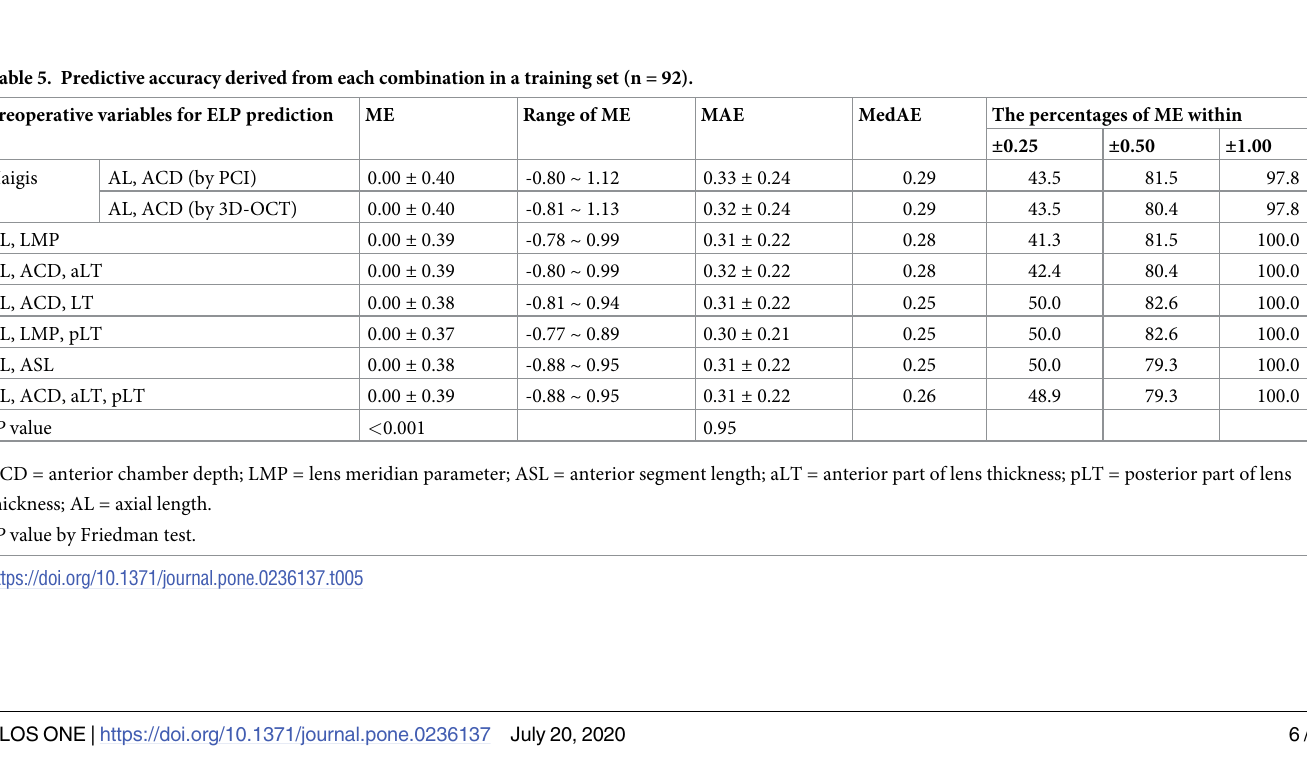
value = 0.40). Notably, the combinations of AL, LMP, and pLT, and of AL, ACD, aLT and pLT both showed the strongest correlation and smallest standard deviation of ELP prediction error (R 2 = 0.43, ELP error = 0.00 ± 0.28, respectively). Predictive accuracy derived from each combination is listed in Table 5. The combination of AL, LMP, and pLT yielded the smallest standard deviation of ME, narrowest range of ME, smallest maximum error, smallest MAE, smallest MedAE, and highest percentages within ± 0.25, ± 0.50, and ± 1.00 diopters. Fig 2 shows the correlation between preoperative LT and prediction error derived from each combination. The combinations of AL and ACD show significant negative correlations with preoperative LT (r = 0.23, P = 0.021 for AL and ACD by PCI; r = 0.22, P = 0.030 for AL and ACD by 3D-OCT). The Haigis formula, results in a more hyperopic result when the pre- operative cataractous lens becomes thicker. On the other hand, prediction errors in six other combinations using LMP, LT, aLT, pLT, and ASL did not show a significant correlation with preoperative LT.